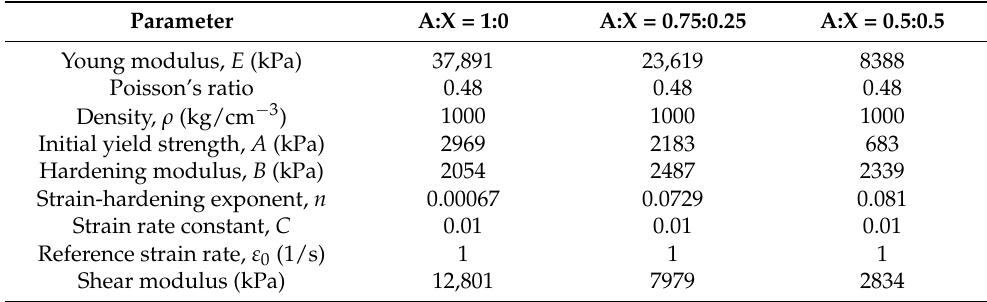
Table 1. Agarose-xanthan gel properties and Johnson–Cook parameters. A is agarose and X is